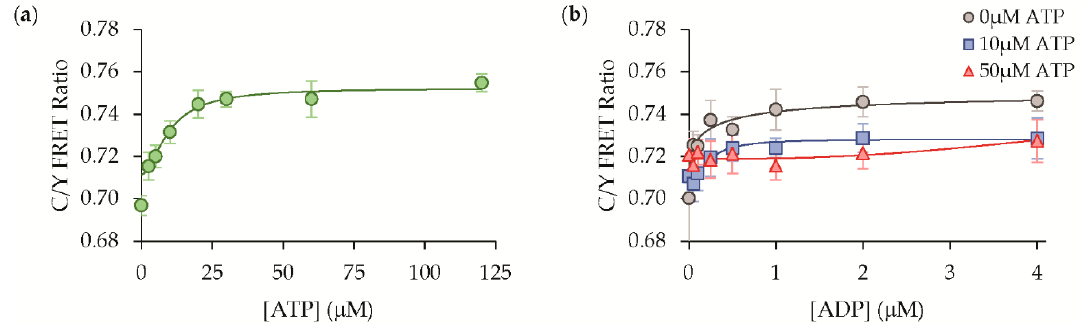
Figure 6. ATP binding and interference. ( a ) ATP elicits a fluorescence response with a significantly lower apparent affinity of K d = 9.9 ± 6.3 µM in solution studies, maintaining a > 50-fold selectivity for ADP over ATP. ( b ) Increasing concentrations of ATP can attenuate the response of the sensor to ADP (10 mM ATP, K d = 0.22 ± 0.09 mM; 50 mM ATP, no fit; mean ± std, n = 6).